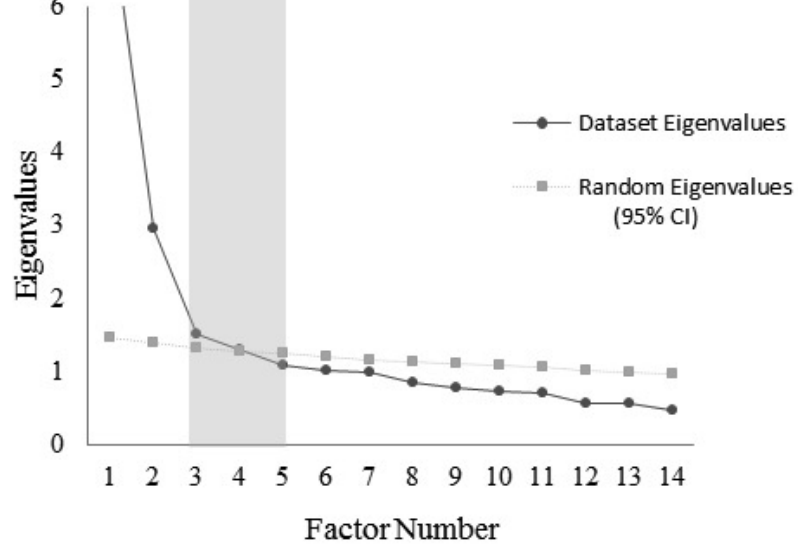
Figure 1 . Scree-plot of the empirical eigenvalues and random eigenvalues of the